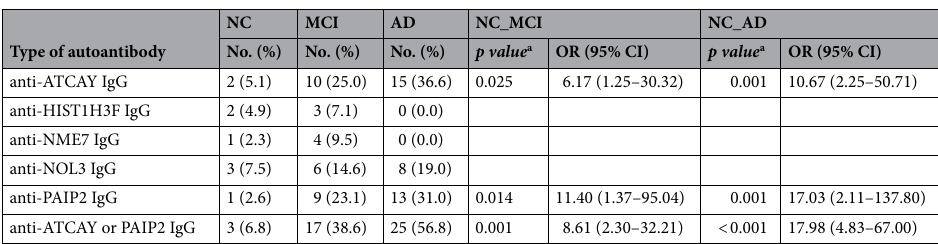
Table 2. Occurrence and risk assessment of a single autoantibody or the combined autoantibodies for the diagnostics of MCI and AD. The cutoff value for positive autoantibody levels (normalized by total IgG) was set as mean plus 2 standard deviations (SD) of NC. a Significance differences for occurrence of autoantibodies between groups were evaluated by Chi-square test or Fisher exact test, as